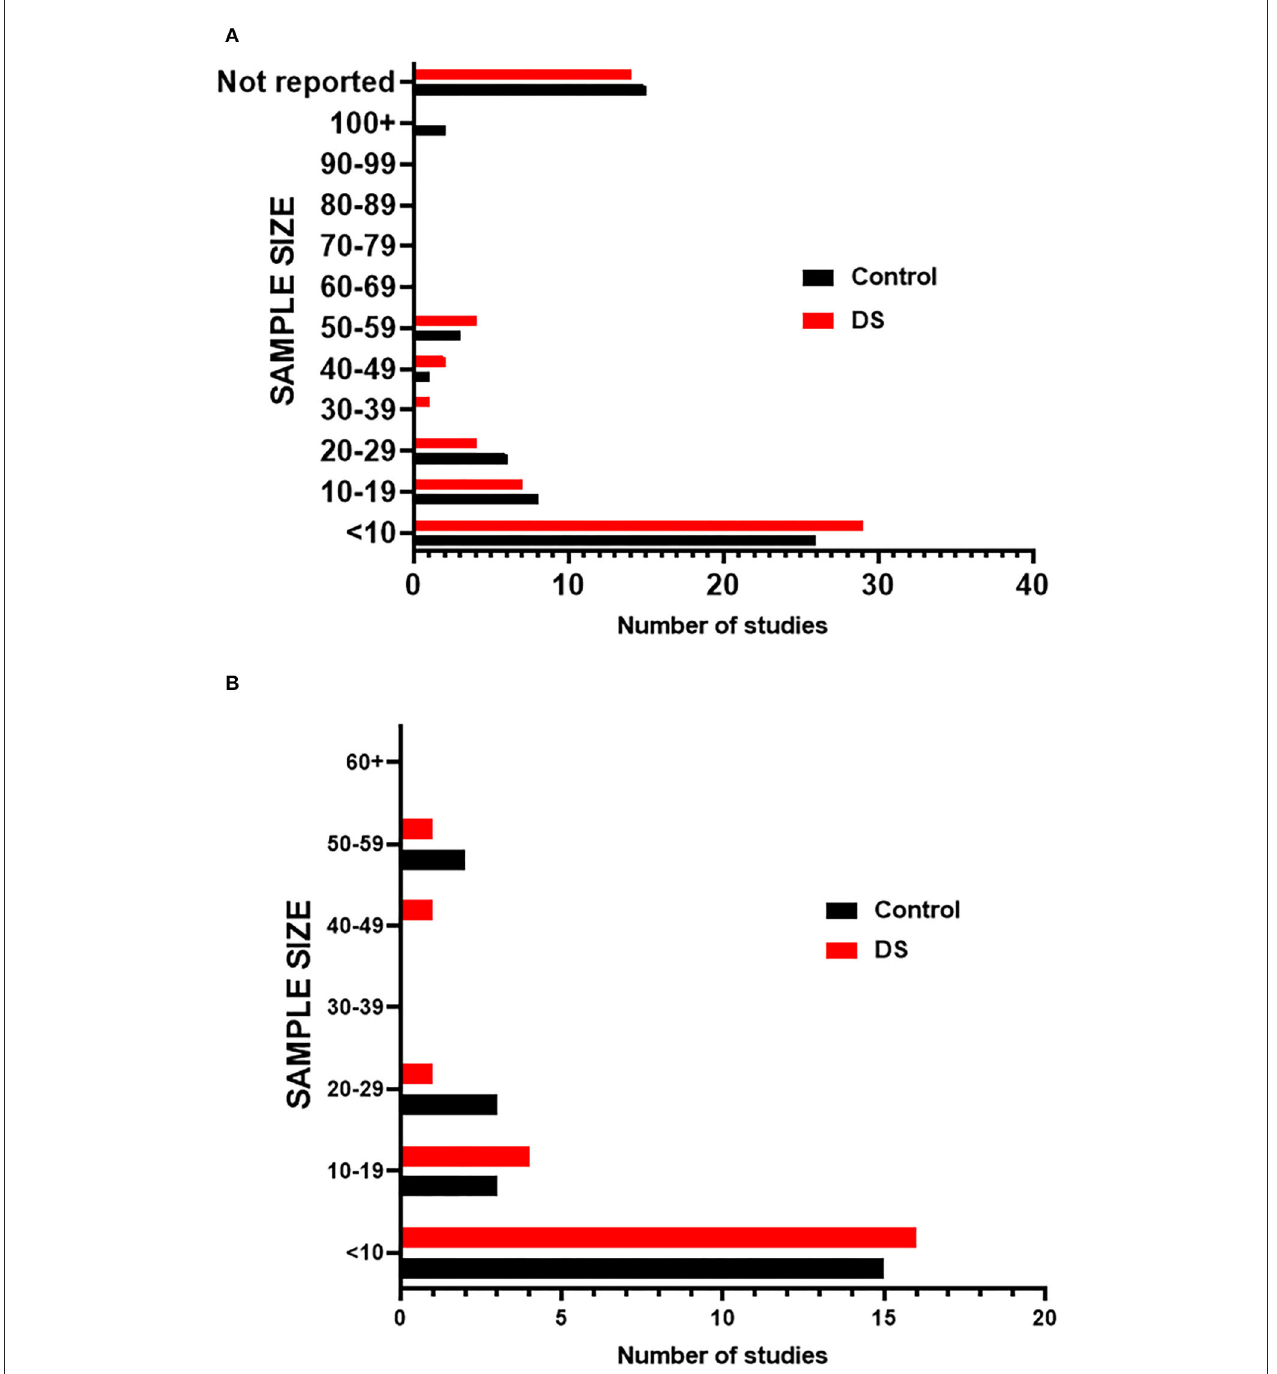
FIGURE 3 | Sample sizes of studies. (A) Graph indicates the number of studies that fall within a given sample size range for both Control and DS samples in screened publications. (B) Graph indicates the number of studies that fall within a given sample size range for both Control and DS samples in publications included in